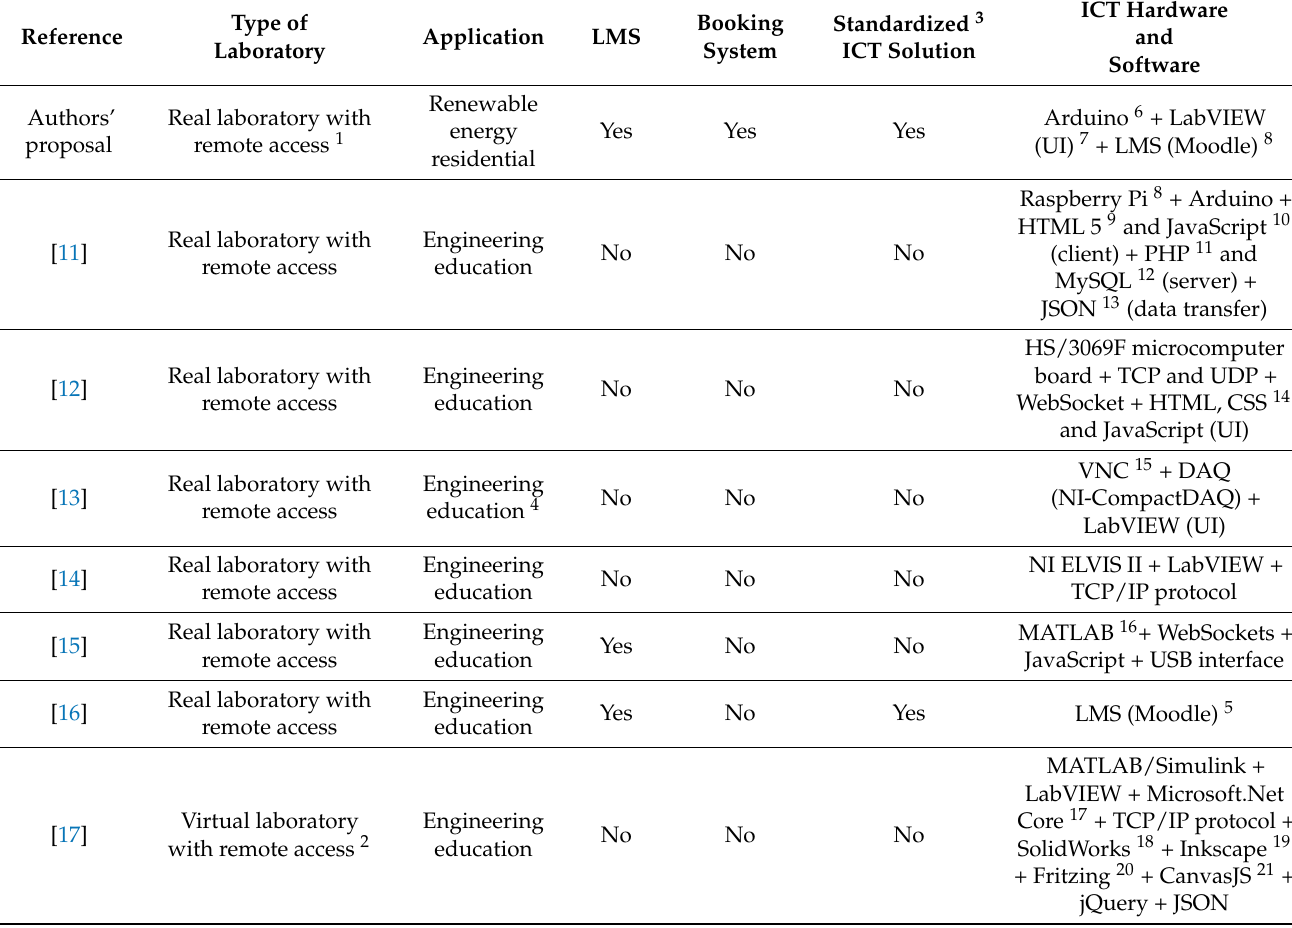
Table 1. Comparison of design and implementation of remote laboratories in